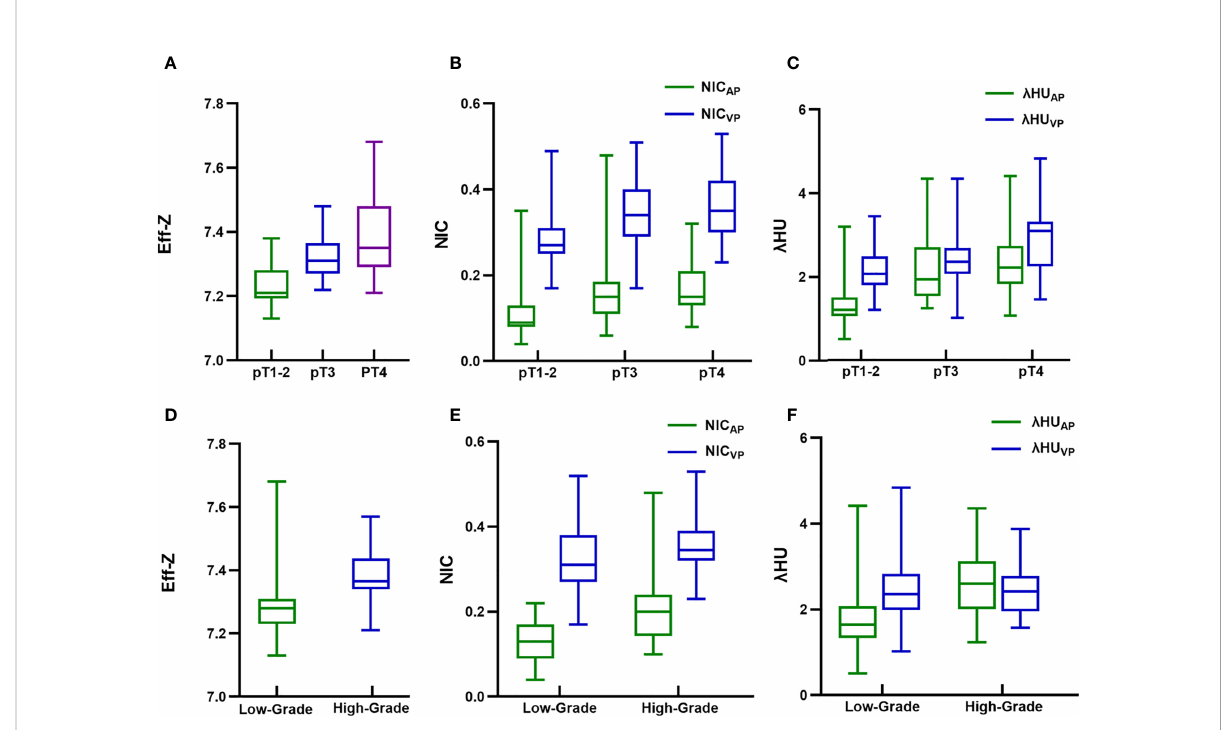
FIGURE 2 Box and whisker plots of (A) effective atomic number (Eff-Z) in pre-contrast phase, (B) normalized iodine concentration (NIC) in arterial and venous phase (VP), (C) spectral HU curve ( l HU) in arterial and VP of different pathological tumor (pT) stage colorectal adenocarcinoma (CRAC); (D) Eff-Z in pre-contrast phase, (E) NIC in arterial and VP, (F) l HU in arterial and VP of high- and low-grade CRAC. Boxes show the upper and lower quartiles, and horizontal lines within boxes indicate median values. Whiskers represent the 95th and fi fth percentiles. High- and low-grade CRAC showed no difference in l HU from VP ( P >0.05), whereas differences in the rest of quantitative parameter values were observed between different pT stages and histologic grades (all P